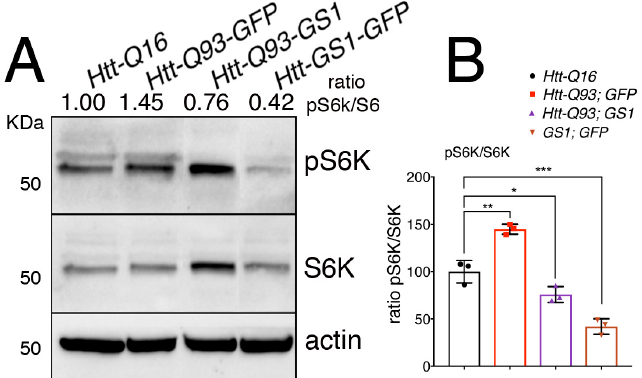
Figure 6. Expression of GS1 in neurons reduces S6K phosphorylation. ( A ) Western blot showing the level of phosphorylated S6K on Thr 398 and of S6K in lysates within 10 heads from animals expressing the indicated transgenes in neurons using the elav-Gal4 driver. Actin was used as the loading control. ( B ) Graphic representing the ratio of S6K phosphorylation versus the unphosphorylated form of the protein. The ratio between pS6K/S6K was calculated from three independent experiments. One-way ANOVA p -values: *** p < 0.001, ** p < 0.01, * p < 0.05 were calculated from three independent experiments, error bars indicate the standard deviations. Cells 2020 , 9 , x